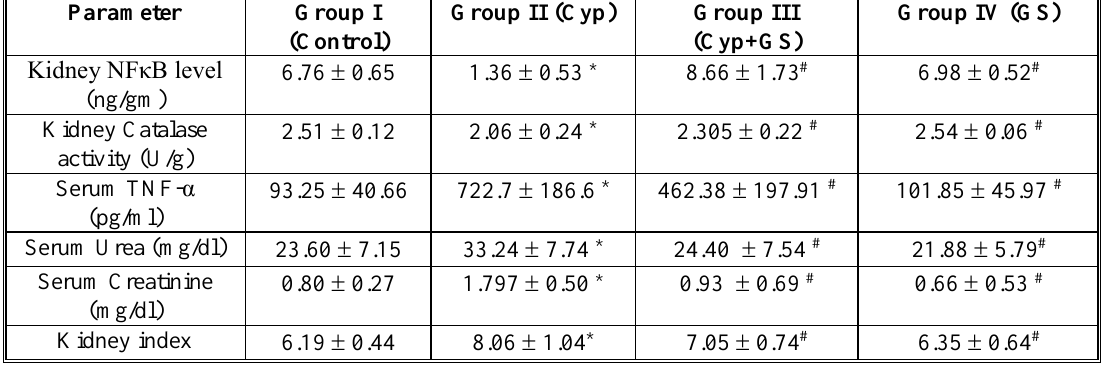
Table 1. Effect of Guggulsterone on the kidney parameters in the cyclophosphamide-treated rats. Parameter